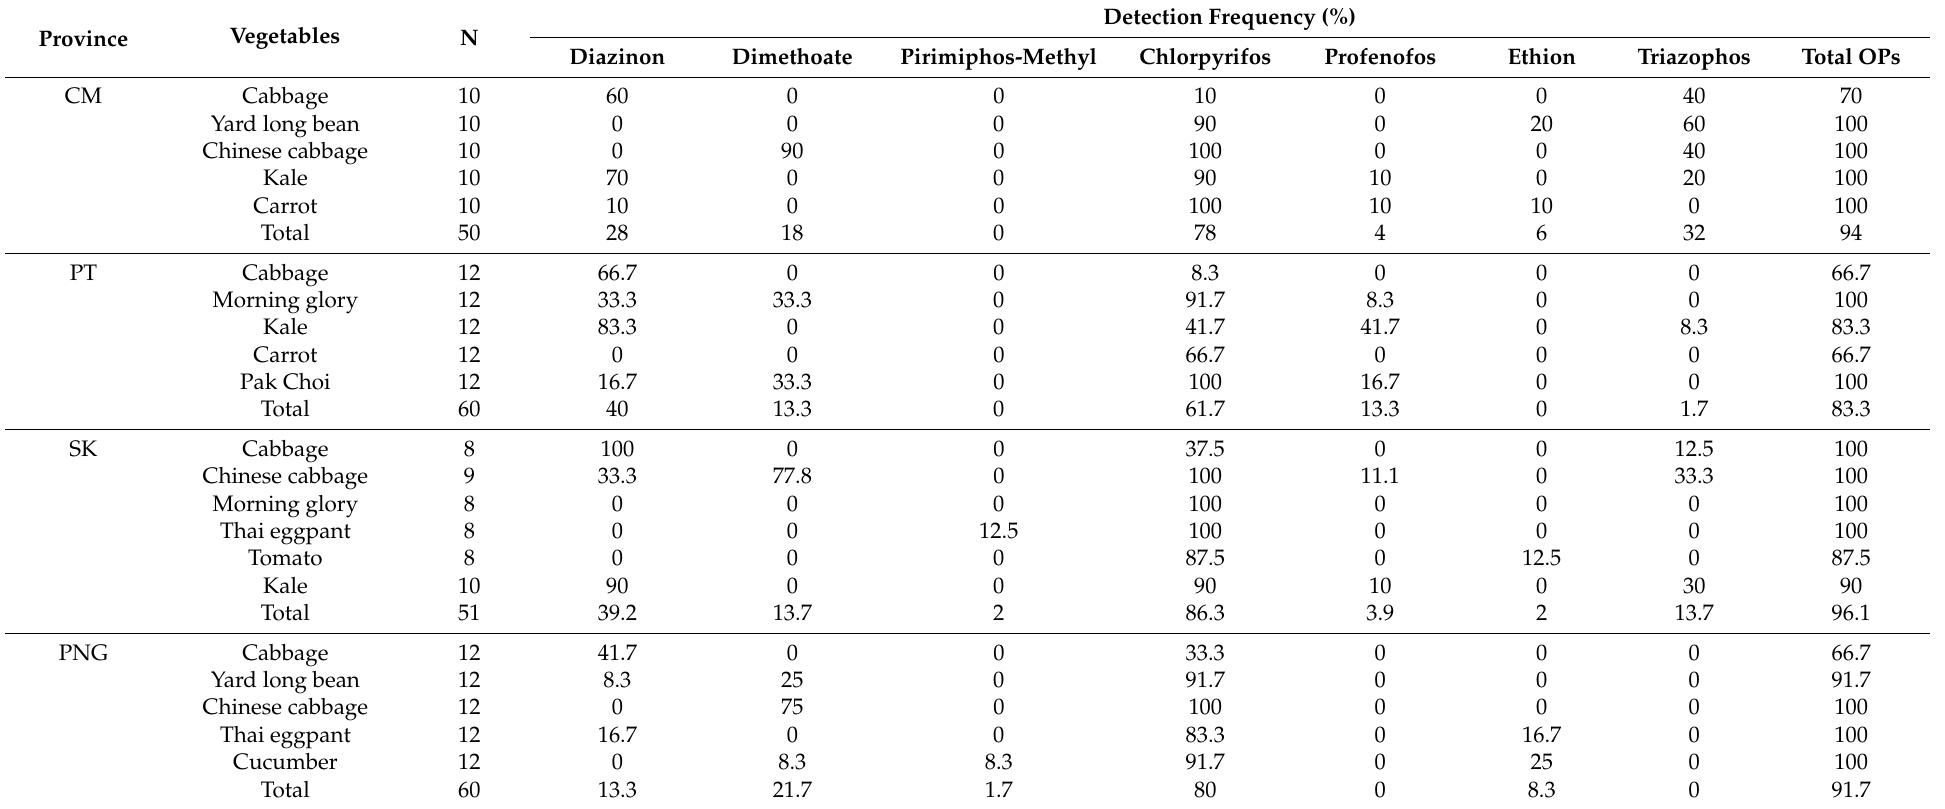
Table 2. Comparison of residue detection frequency by province based on the